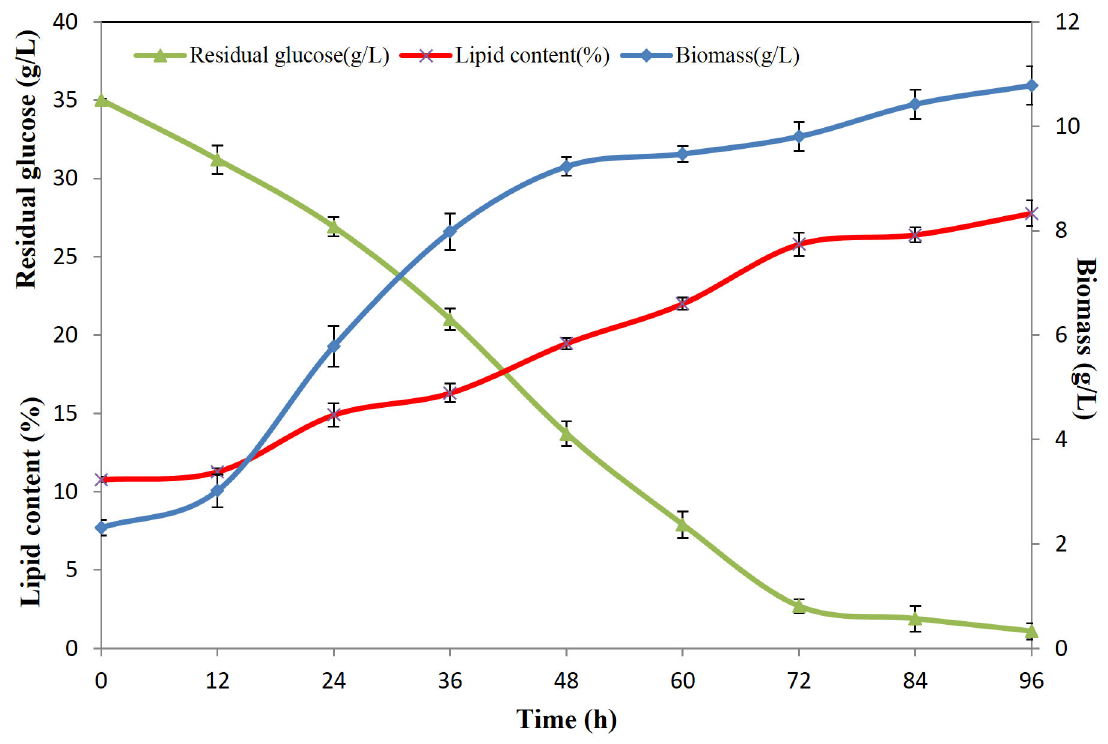
Figure 4. Substance level dynamic change of C. albidus . Biomass (g/L), residual glucose (g/L) and lipid content (%) at different time points were